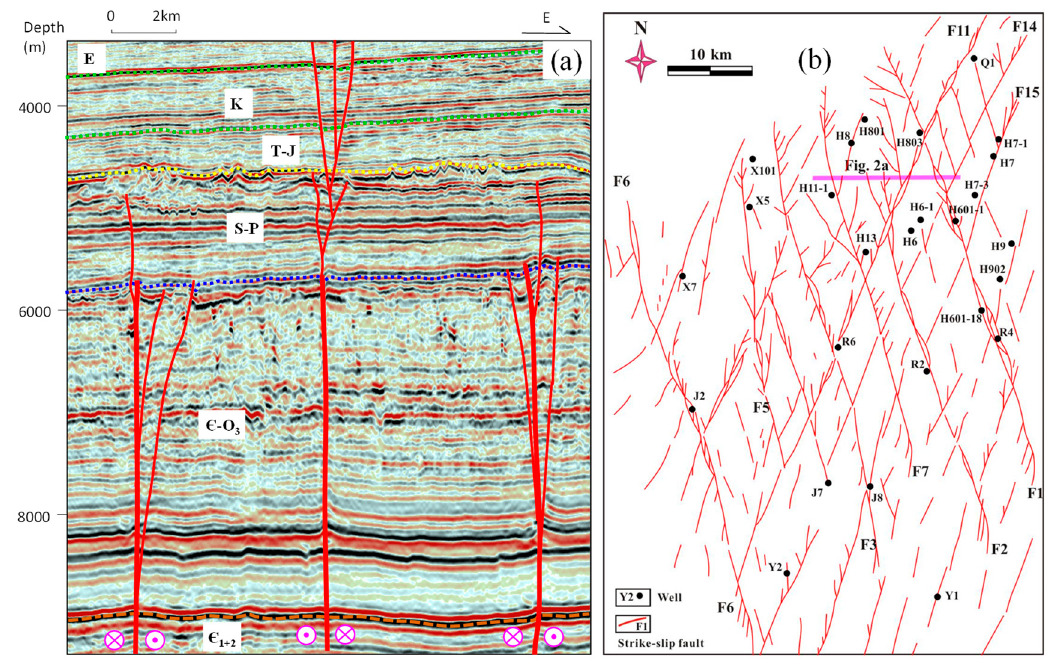
Figure 2. ( a ) Typical seismic sections showing the strike-slip faults (the strata symbols are same with Figure 1), and ( b ) the map view of the strike-slip fault system affecting the Ordovician carbonate sequence (~6500–7500 m) in the Halahatang area, Tarim Basin (Modified from [30]).